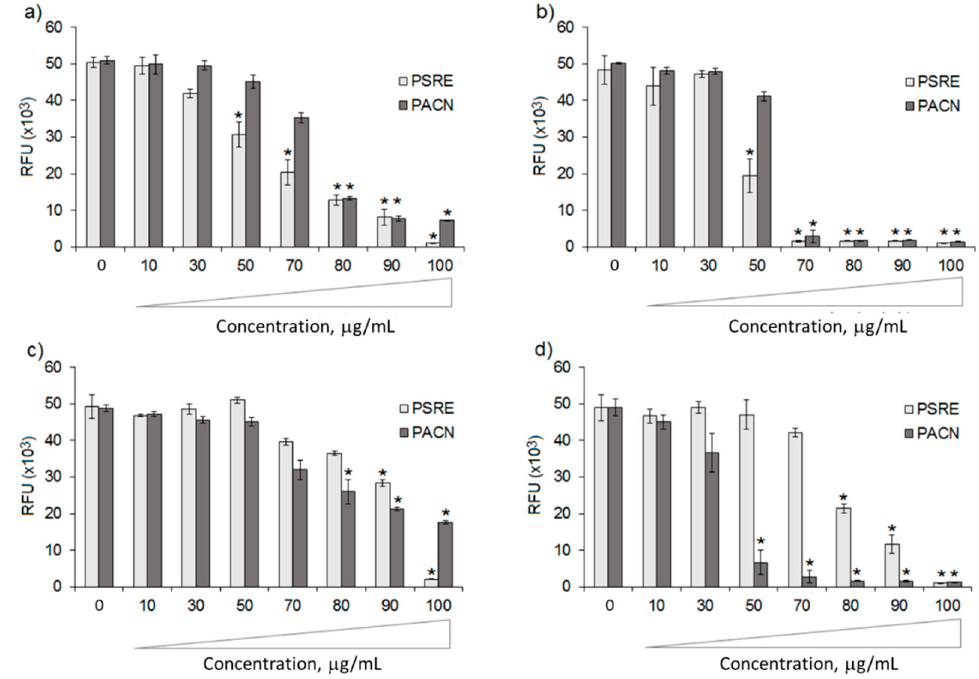
Figure 1. Antibacterial activity of Pelargonium sidoides root extract (PSRE) and proanthocyanidins from PSRE (PACN) towards Staphylococcus aureus ( a ), S. epidermidis ( b ), Escherichia coli ( c ) and Aggregatibacter actinomycetemcomitans ( d ). RFU—relative fluorescence units. Bars represent means and standard deviations of six experimental replicates. * = p < 0.05 vs. untreated control.